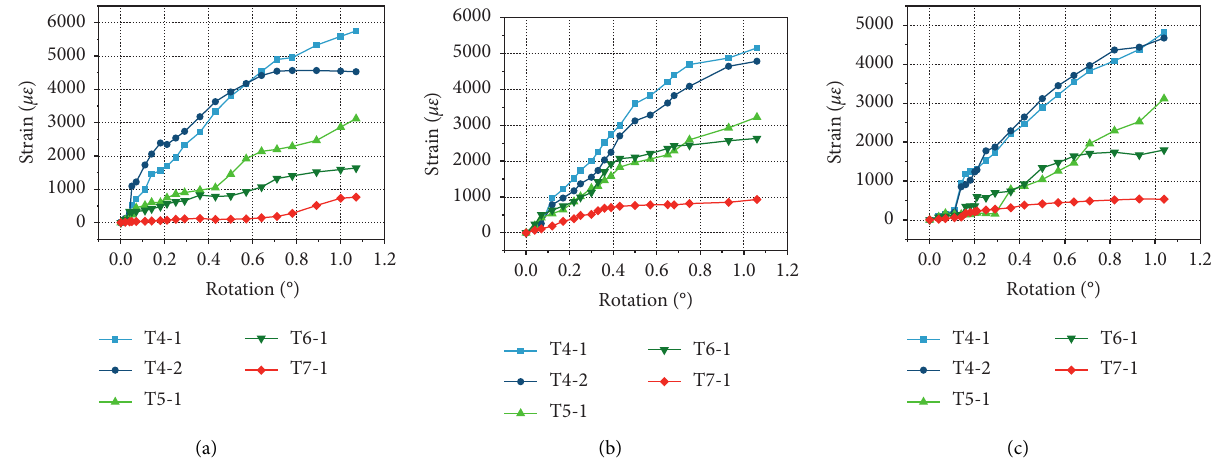
Figure 8: Rotation-strain relationships of UHPC slabs: (a) CB-1, (b) CB-2, and (c) CB-3.